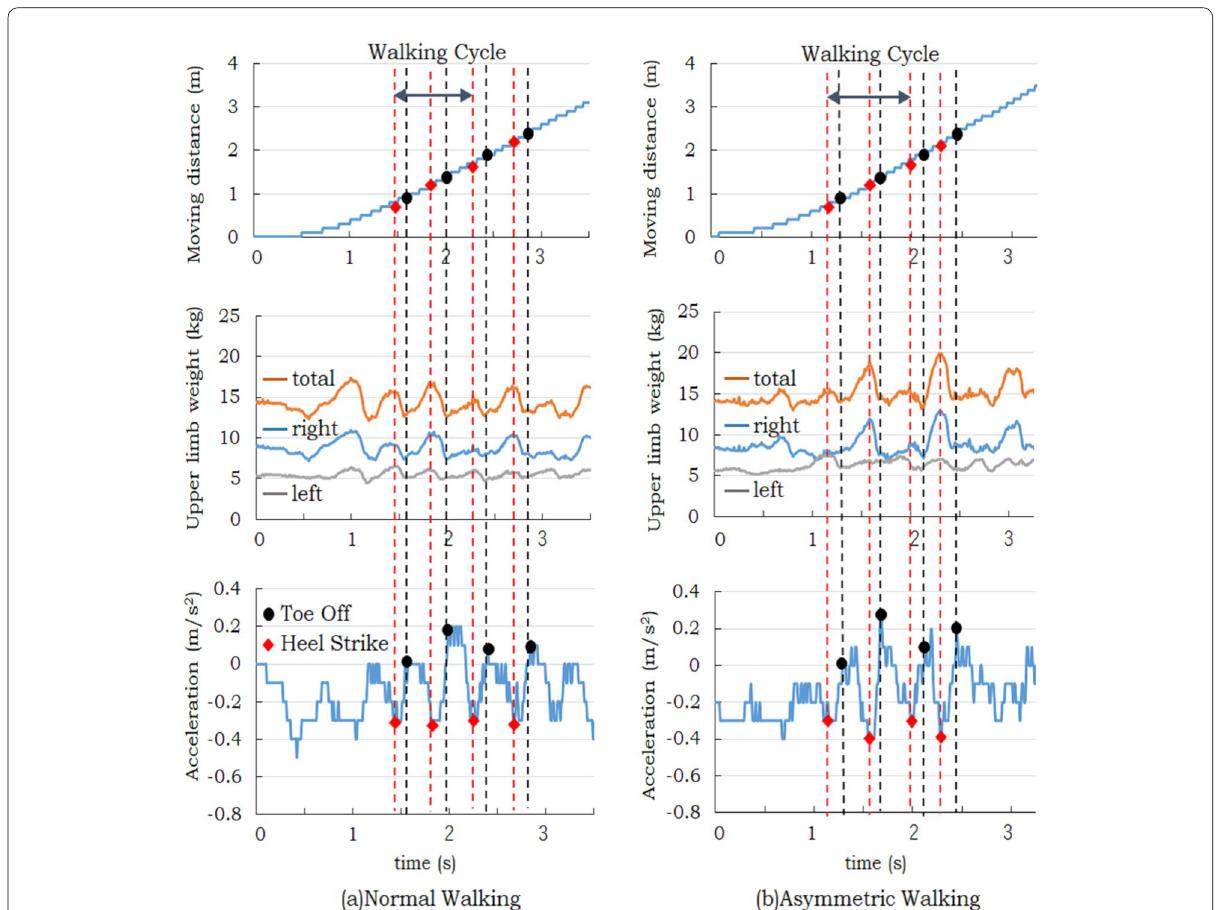
Fig. 12 Measurement results under a target rUW of 30%— a normal walking and b using the footwear with the attached 4 cm block on the sole of the right foot (to simulate asymmetric